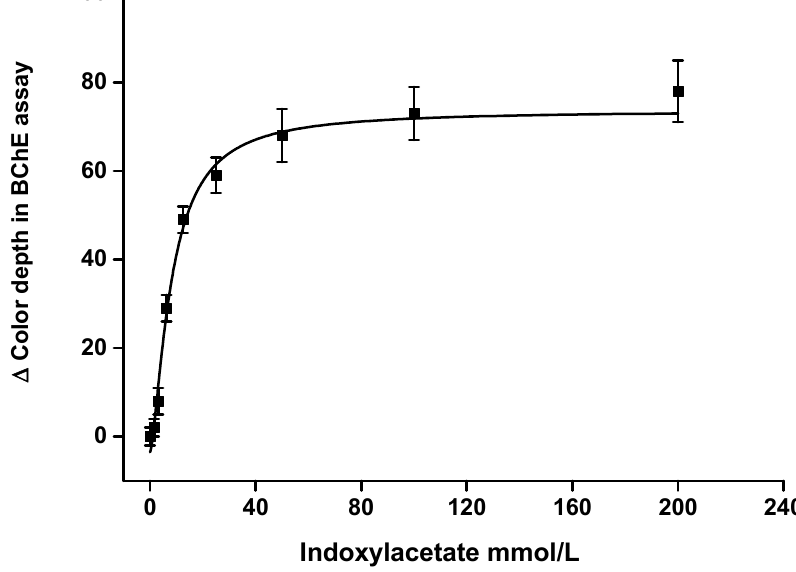
Figure 4. Saturation curve for indoxylacetate applied on a measuring pad with butyrylcholinesterase (BChE) 50 µkat/mL. The concentration is expressed for 10 µL of sample. R (red) channel and 60 min incubation were chosen for this experiment. Standard error of the mean is expressed for five independent repeats.